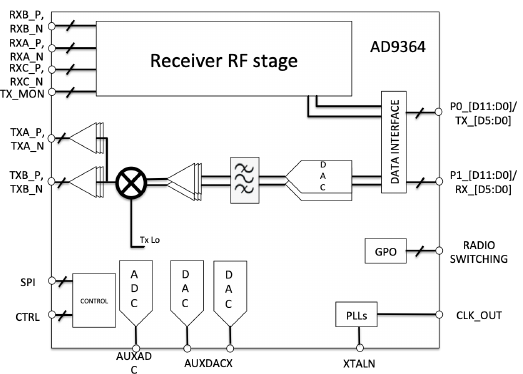
Figure 5. Block diagram of the IC AD9364. In this figure, the AD9364 manufacturer describes how it connects